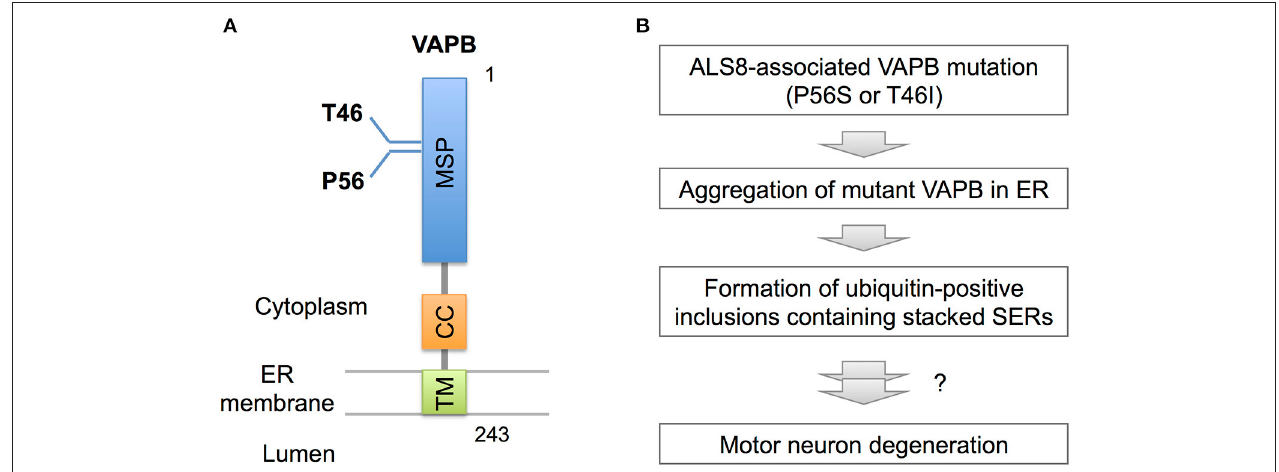
FIGURE 3 | VAPB mutations and SER pathology. (A) Domain structure of VAPB. VAPB is composed of the 125-residue major sperm protein (MSP), coiled coil (CC), and transmembrane (TM) domains. The residues Thr46 and Pro56 are mutated to Ile and Ser, respectively, in familial ALS (ALS8). (B) A model for VAPB-pathology in ALS8. The mutant VAPB proteins are insolubilized and aggregated in ER, leading to formation of ubiquitin-positive inclusions containing stacked SER. The direct link of ER pathology to motor neuron degeneration is still uncertain, however.